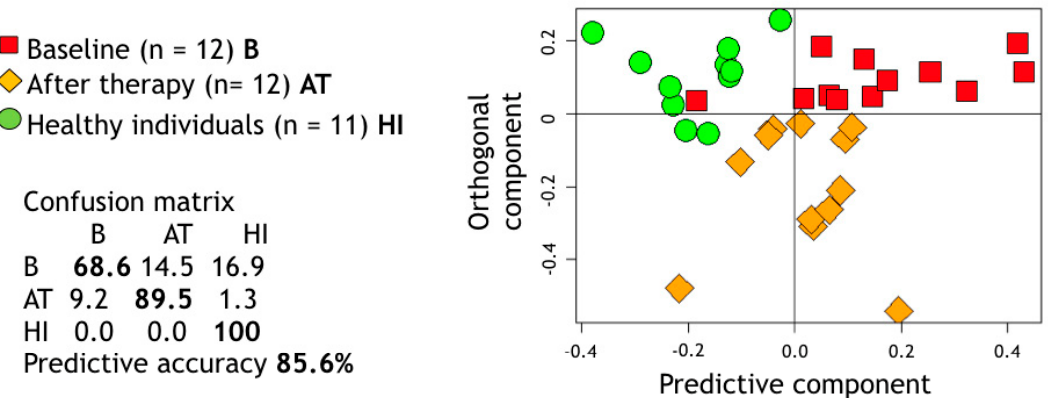
Figure 2. Projection of the proton nuclear magnetic resonance ( 1 H NMR) spectral buckets on the two dimensions of the Orthogonal Projections to Latent Structures-Discriminant Analysis (OPLS-DA) considering the subspace for healthy individuals (HI) and generalized periodontitis (GP) patients at two di ff erent treatment stages (baseline, B, and after treatment, A)T. The relative confusion-matrix and overall predictive accuracy (calculated following 100 runs of Monte Carlo cross validation) are also reported. p -value calculated using a premutation test procedure was <